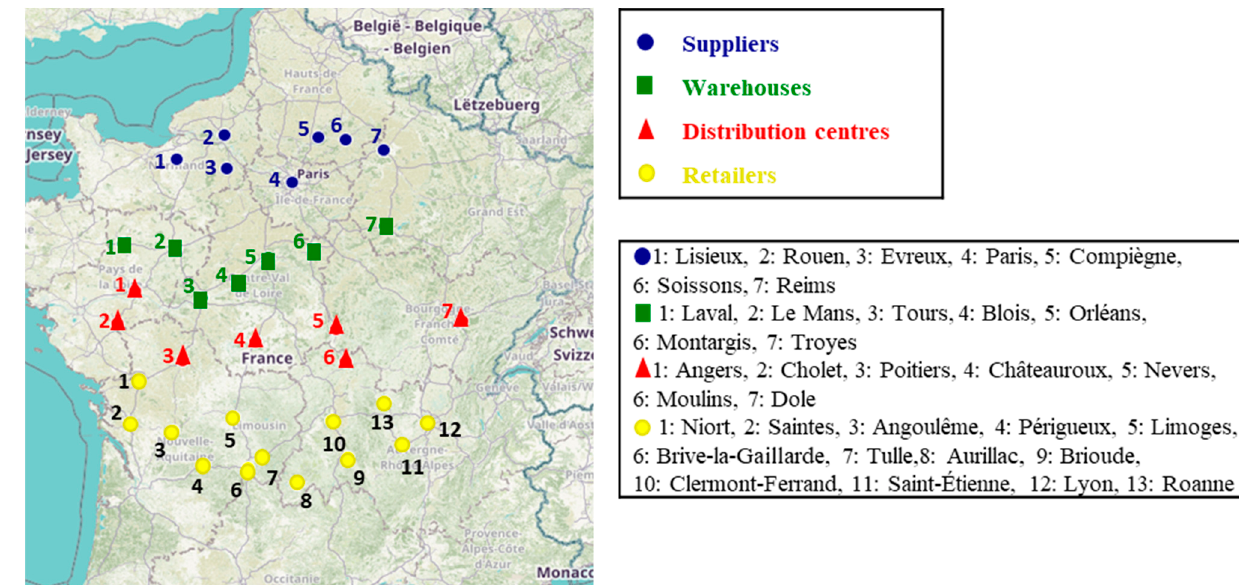
Figure 2. The examined distribution network.